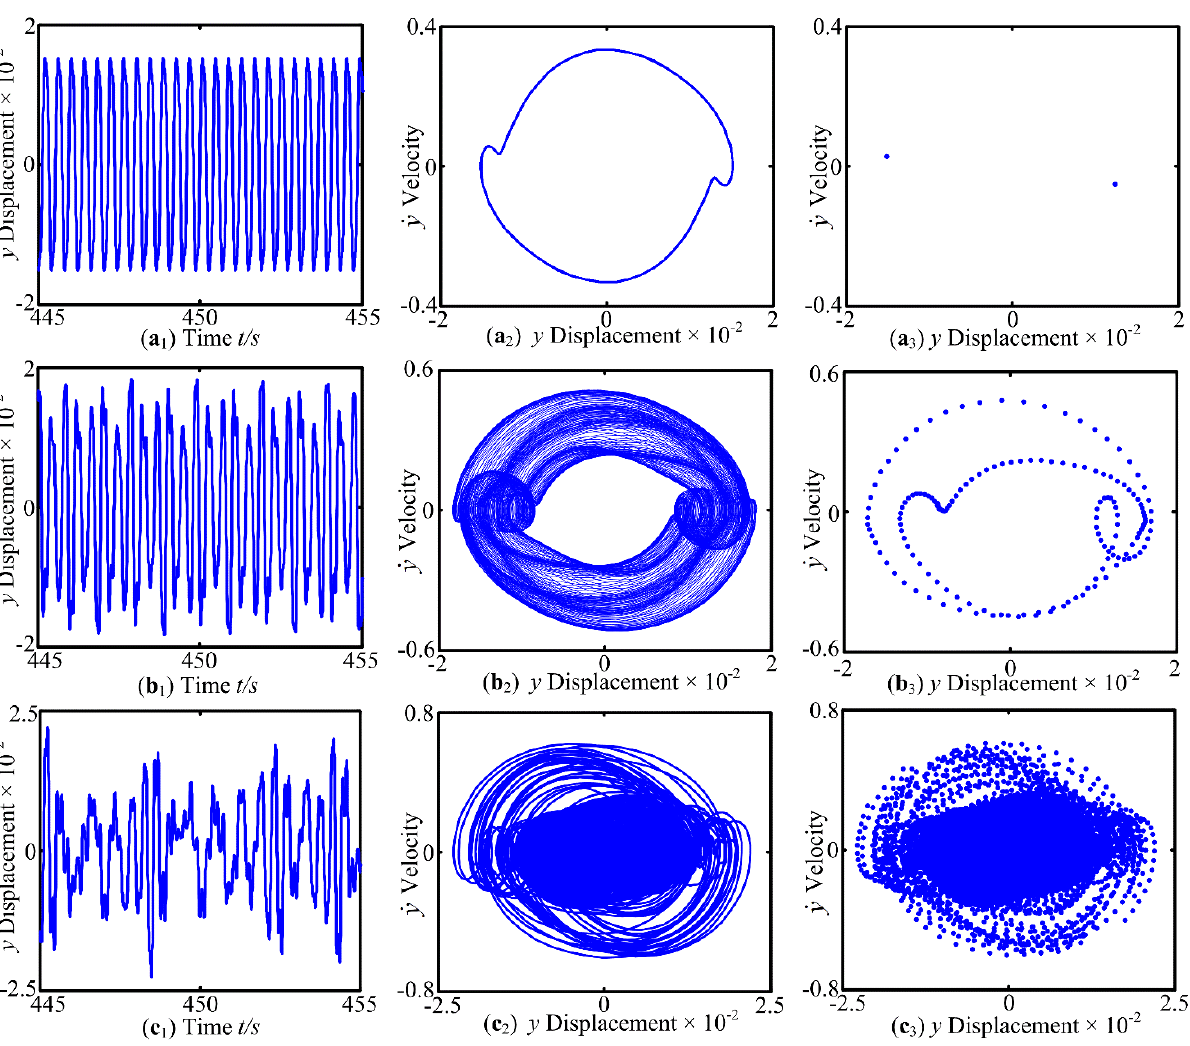
Figure 9. Waveform (1), phase diagram (2) and Poincaré map (3) with β = 0.218 Periodic-2 motion ( a ), β = 0.521 quasi-periodic motion ( b ) and β = 0.752 chaotic motion ( c ).